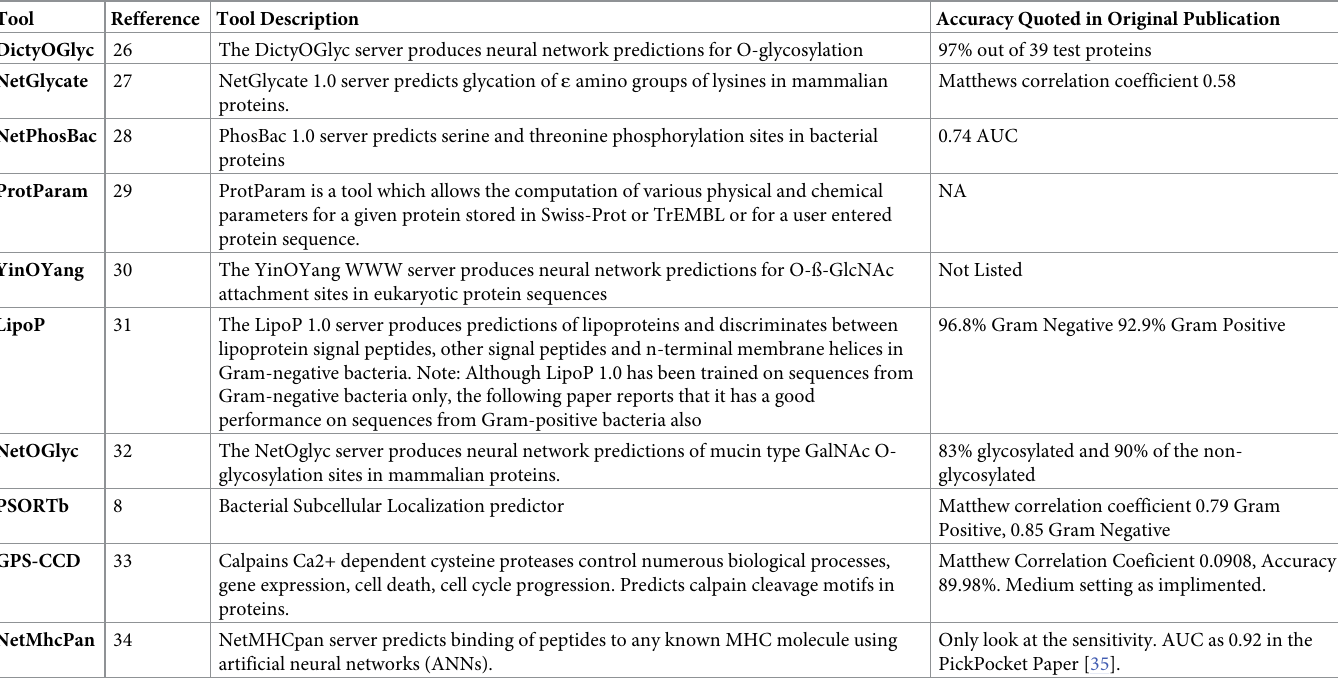
Table 1. The top ten most informative features as determined by greedy backward feature elimination on BPAD200 using logistic regression [26–35].